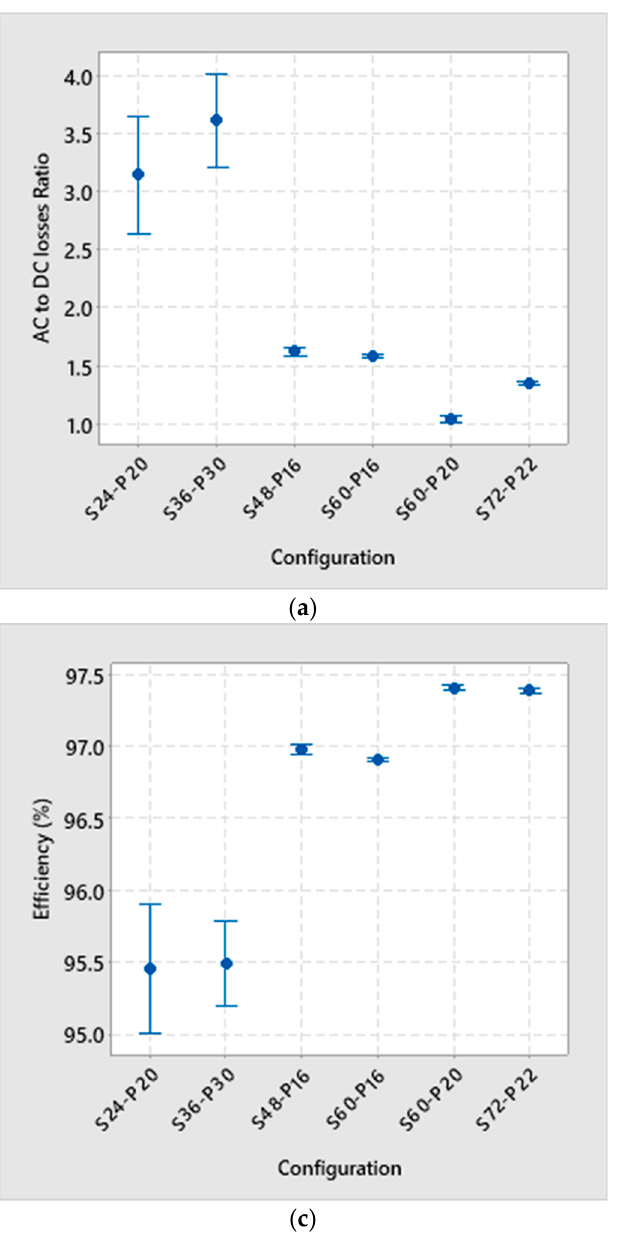
Figure 11. Interval plot of opening study: ( a ) AC to DC loss ratio, ( b ) AC losses in (kW), ( c ) Efficiency (%), and ( d ) THD (5). (%), and ( d ) THD